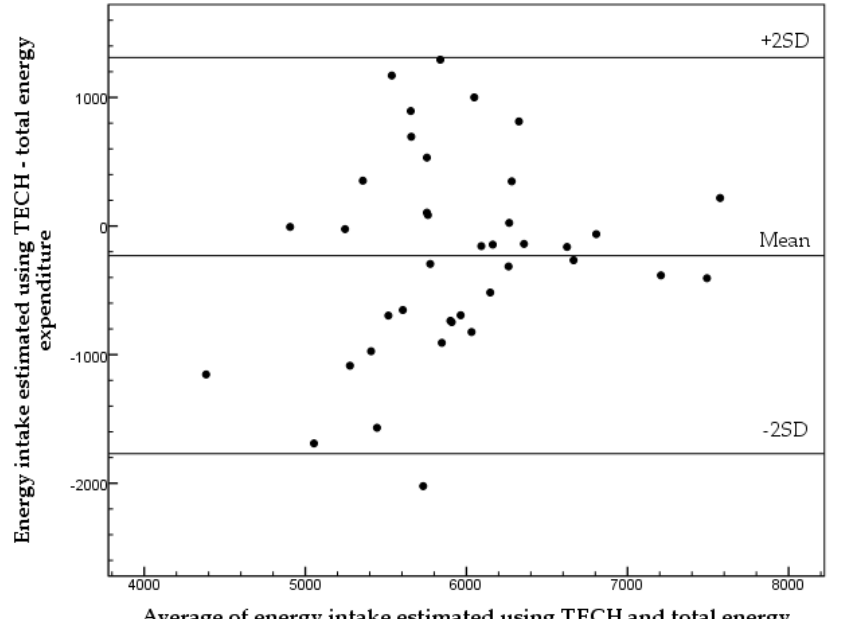
Figure 1. A Bland and Altman plot comparing energy intake using Tool for Energy Balance in Children (TECH) and total energy expenditure measured using the doubly labelled water method in 39 healthy 5.5 year old children. The mean difference between the methods was −220 kJ/24 h with limits of agreement (2SD) of 1540 kJ/24 h. The regression equation was y = 0.253 x − 1733 ( r = 0.215, p = 0.189).